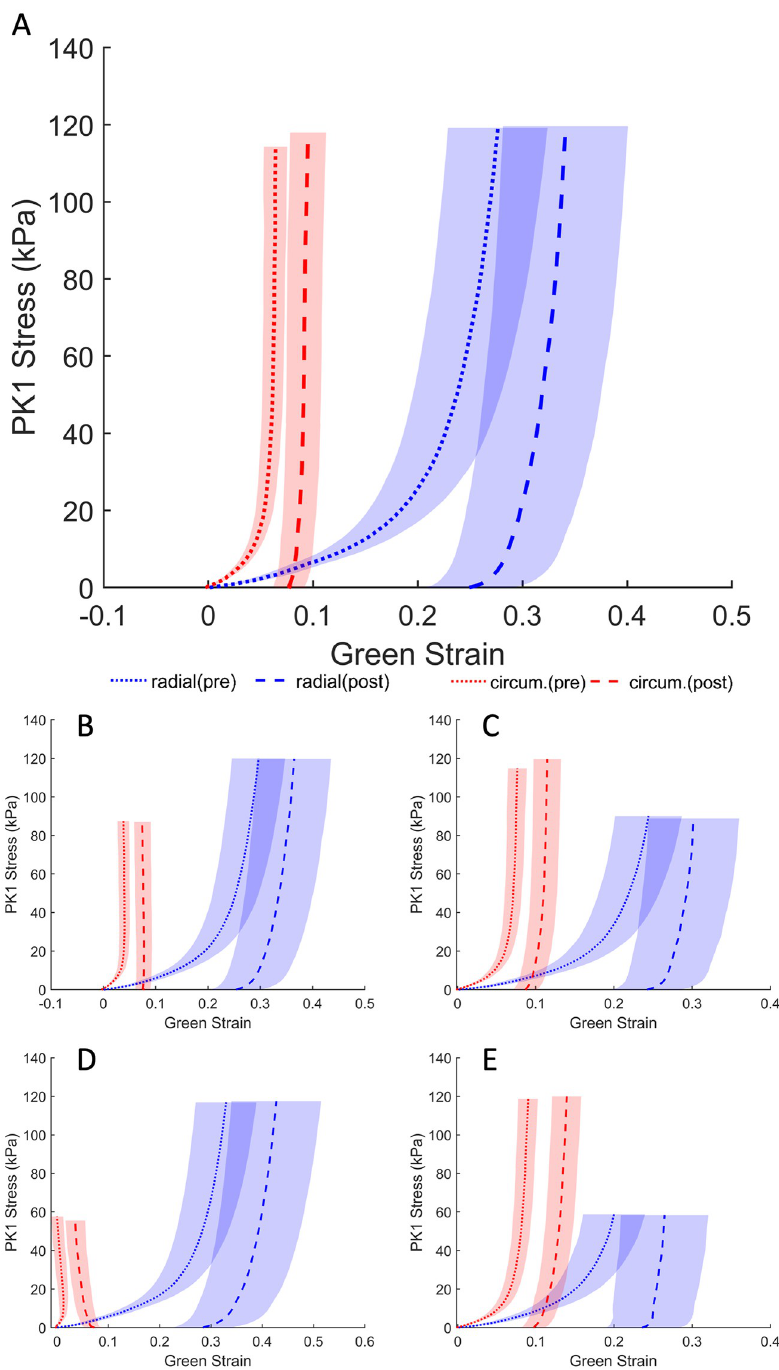
Fig 11. Average first Piola–Kirchoff response of post-elastase samples that reference fiducial marker positions prior to the application of elastase. Loading protocols, in kPa: (A) 120-120, (B) 120-90, (C) 90, 120, (D) 120-60, (E) 60-120. Error bars represent the standard